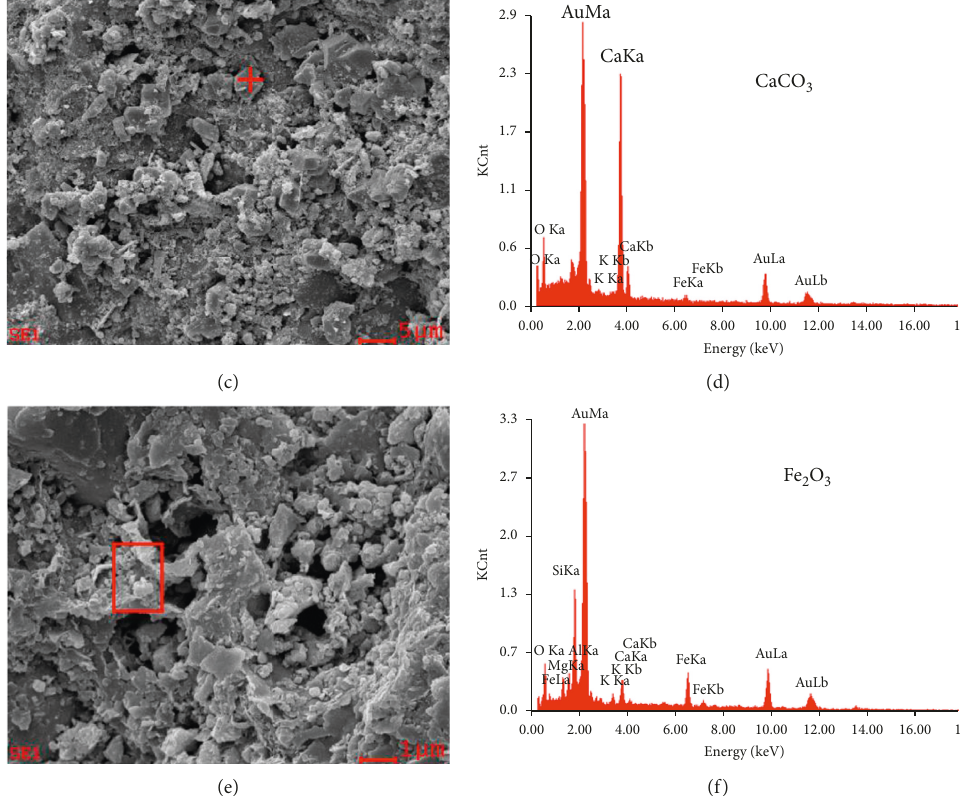
Figure 7: (a, b) SEM images show that shale was eroded by the alkaline solution. EDS maps (c–f) show that CaCO the surface of